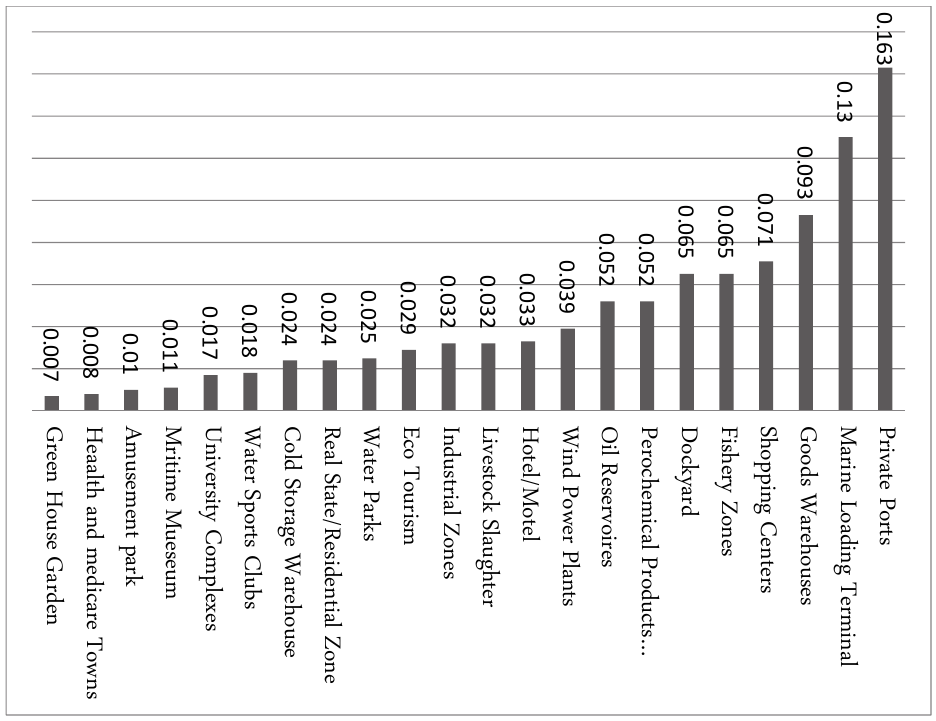
Fig. 1. The weights of investment opportunities for Mokran